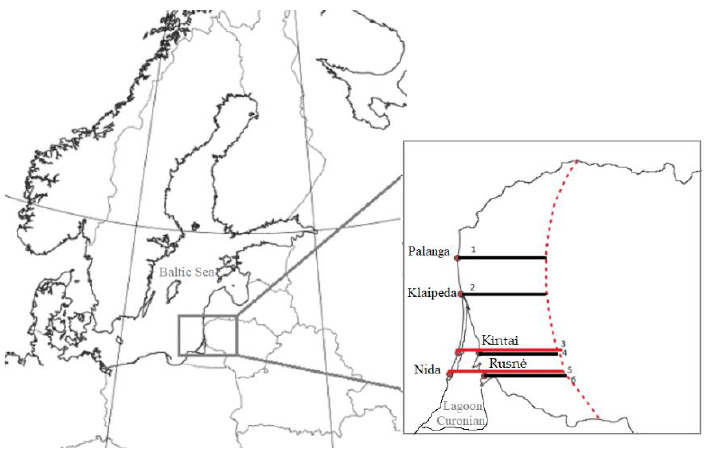
Figure 2. Research area: Baltic Sea, southeast coast, Lithuania.